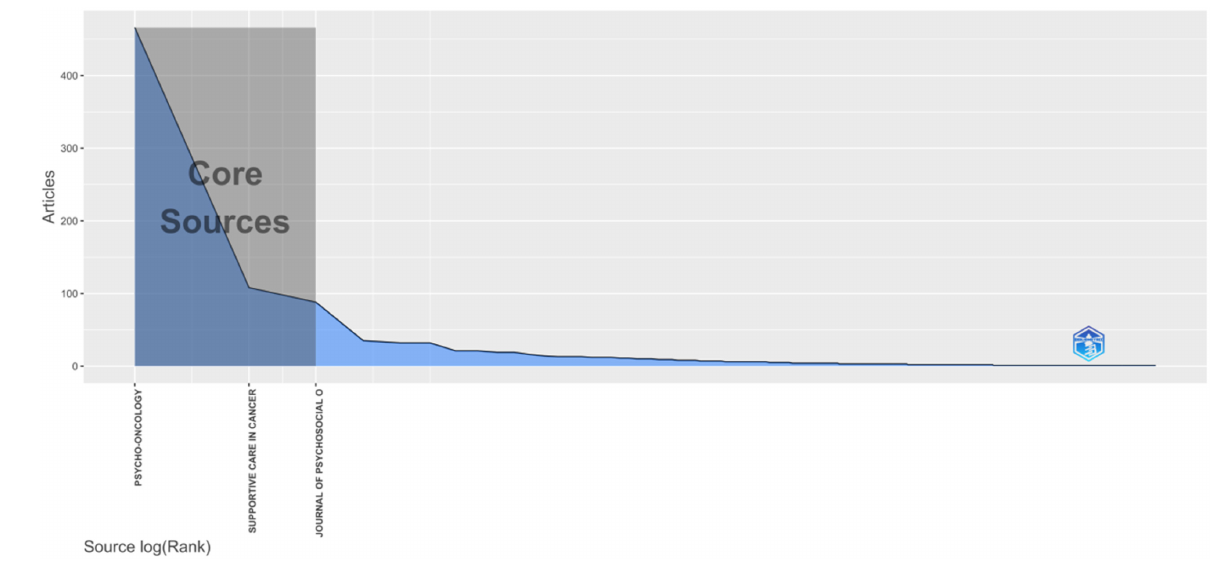
FIGURE 3 | Journals (Sources) clustering through Bradford’s